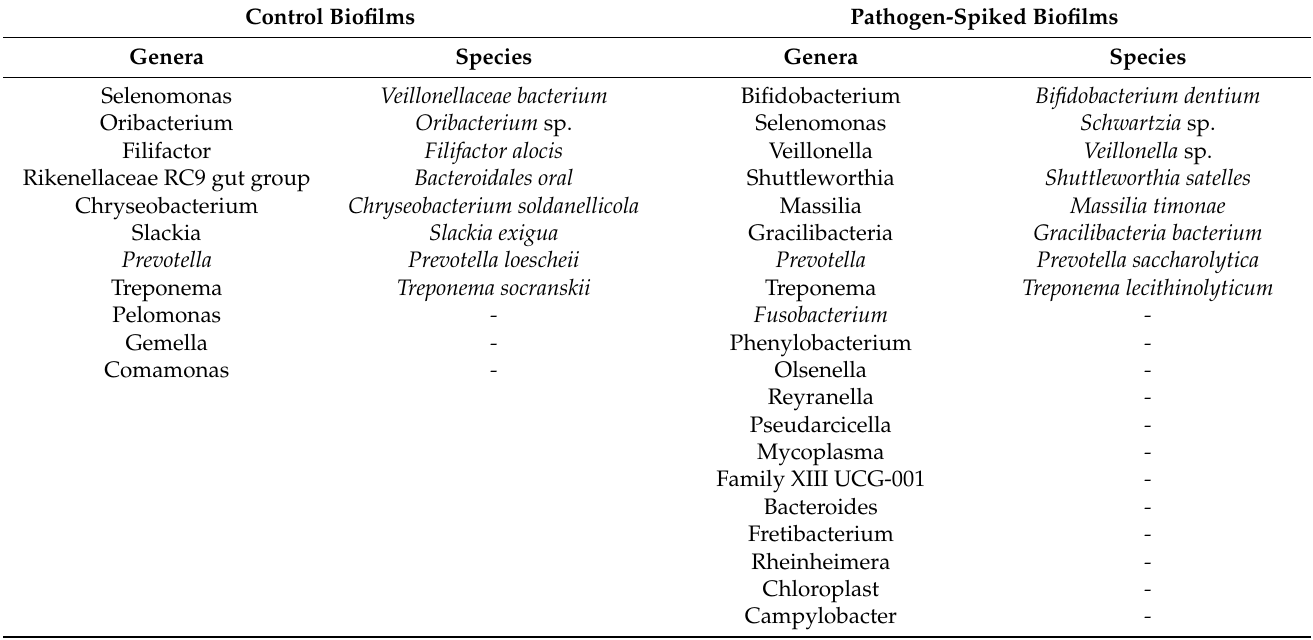
Figure 4. Distinct species and genera found in the pathogen-spiked biofilms compared to control biofilms. Venn diagram showing the comparisons of the microbiome of the different biofilms with the number of genera ( bold ) and species ( italic ) found in the control biofilms (green) and in the pathogen-spiked biofilms (red). Table 1. Distinct genera and species found between control and pathogen-spiked biofilms.